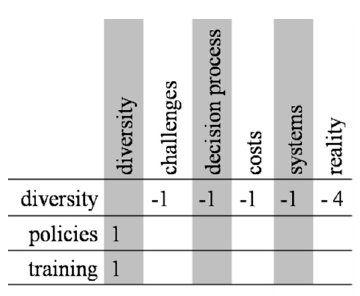
Figure 5. Diversity graph.